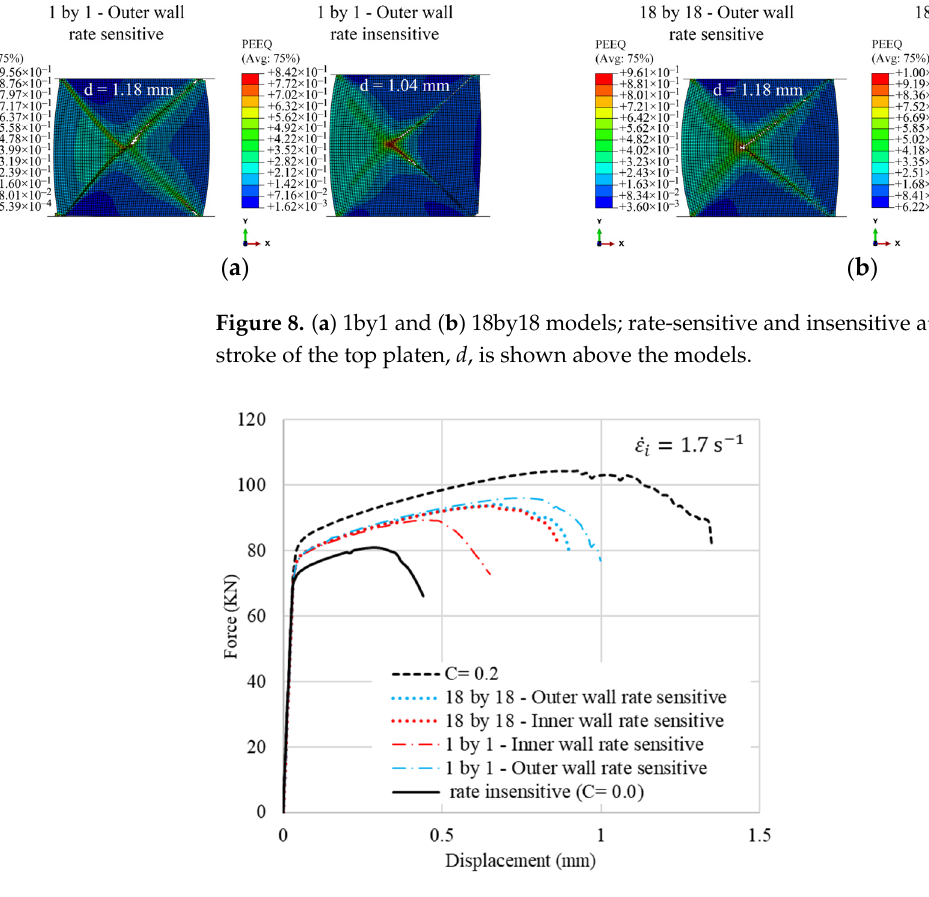
Figure 9. F–d curves of 1by1 and 18by18 models.